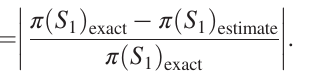
FIG. 2. (a) Double-well potential U ð x Þ . (b) Corresponding stationary distribution at a reduced temperature k the ST simulation. (c) The relative error of π 1 with respect to (w.r.t.) the number of simulation steps for simulations with two solvent particles and four temperatures. The direct histogram estimate (red, dashed line) and xTRAM (black, continuous line) are evaluated on the same data set. (d) Standard deviation ( σ ) from 100 realizations w.r.t. simulation steps taken for direct count histogram (red, dashed line) and xTRAM (black, continuous line). (e, f) Results of the PT simulation. (e) Relative error π 1 w.r.t. to simulation steps from PT simulations over 100 realizations for direct counts (red, dashed line), MBAR (blue, dashed-dotted line), and xTRAM (black, continuous line). (f) Standard deviation from data in (e). (g, h) Results of a system with N ¼ 50 solvent particles using PT simulations for the MBAR and a direct counting estimate and RS simulations for the xTRAM estimate. (g) Relative error as a function of the total number of simulation steps for comparing a 20 temperature replica PT simulation, analyzed with direct count histograms (red, dashed line), and MBAR (blue, dashed-dotted line), with the xTRAM (black, continuous line) analysis of a six-temperature RS simulation. The dashed green line shows a fit of t − 0 . 5 to the tail of the relative error. (h) Standard deviations of data in The results are displayed in the form of a log-log plot of the